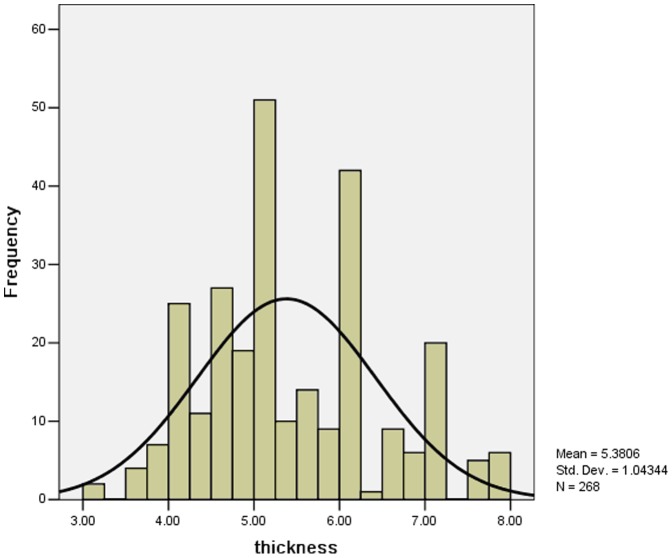
Thickness of pyloric circular muscle (mm).From the Figure 2, we found the mean thickness of pyloric circular muscle ranged from 3 to 8 mm.